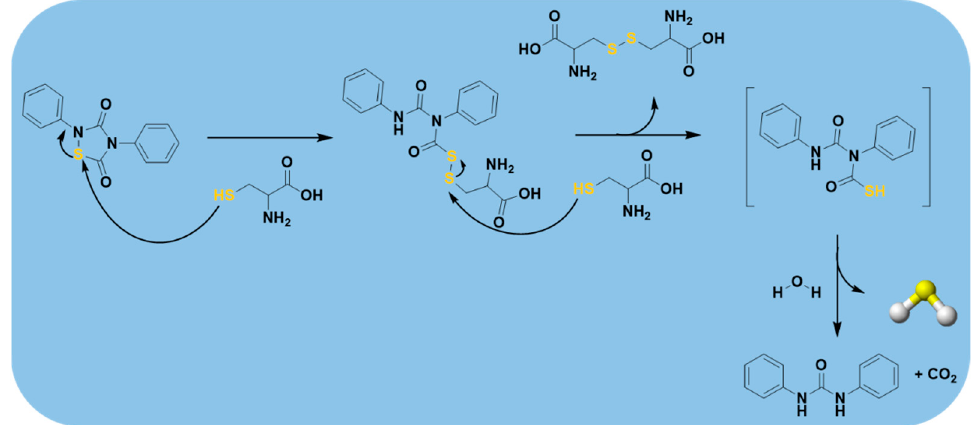
Figure 12. H 2 S-releasing mechanism from 1,2,4-thiadiazolidine-3,5-diones (THIA).